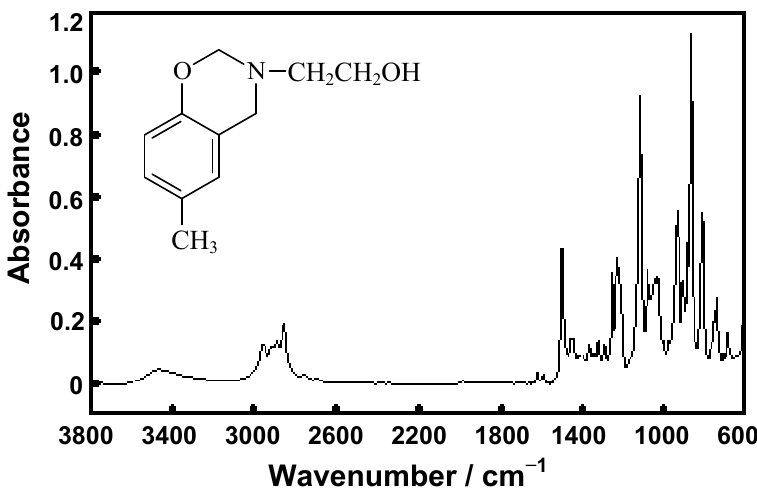
Figure 1. FTIR spectrum of BM1